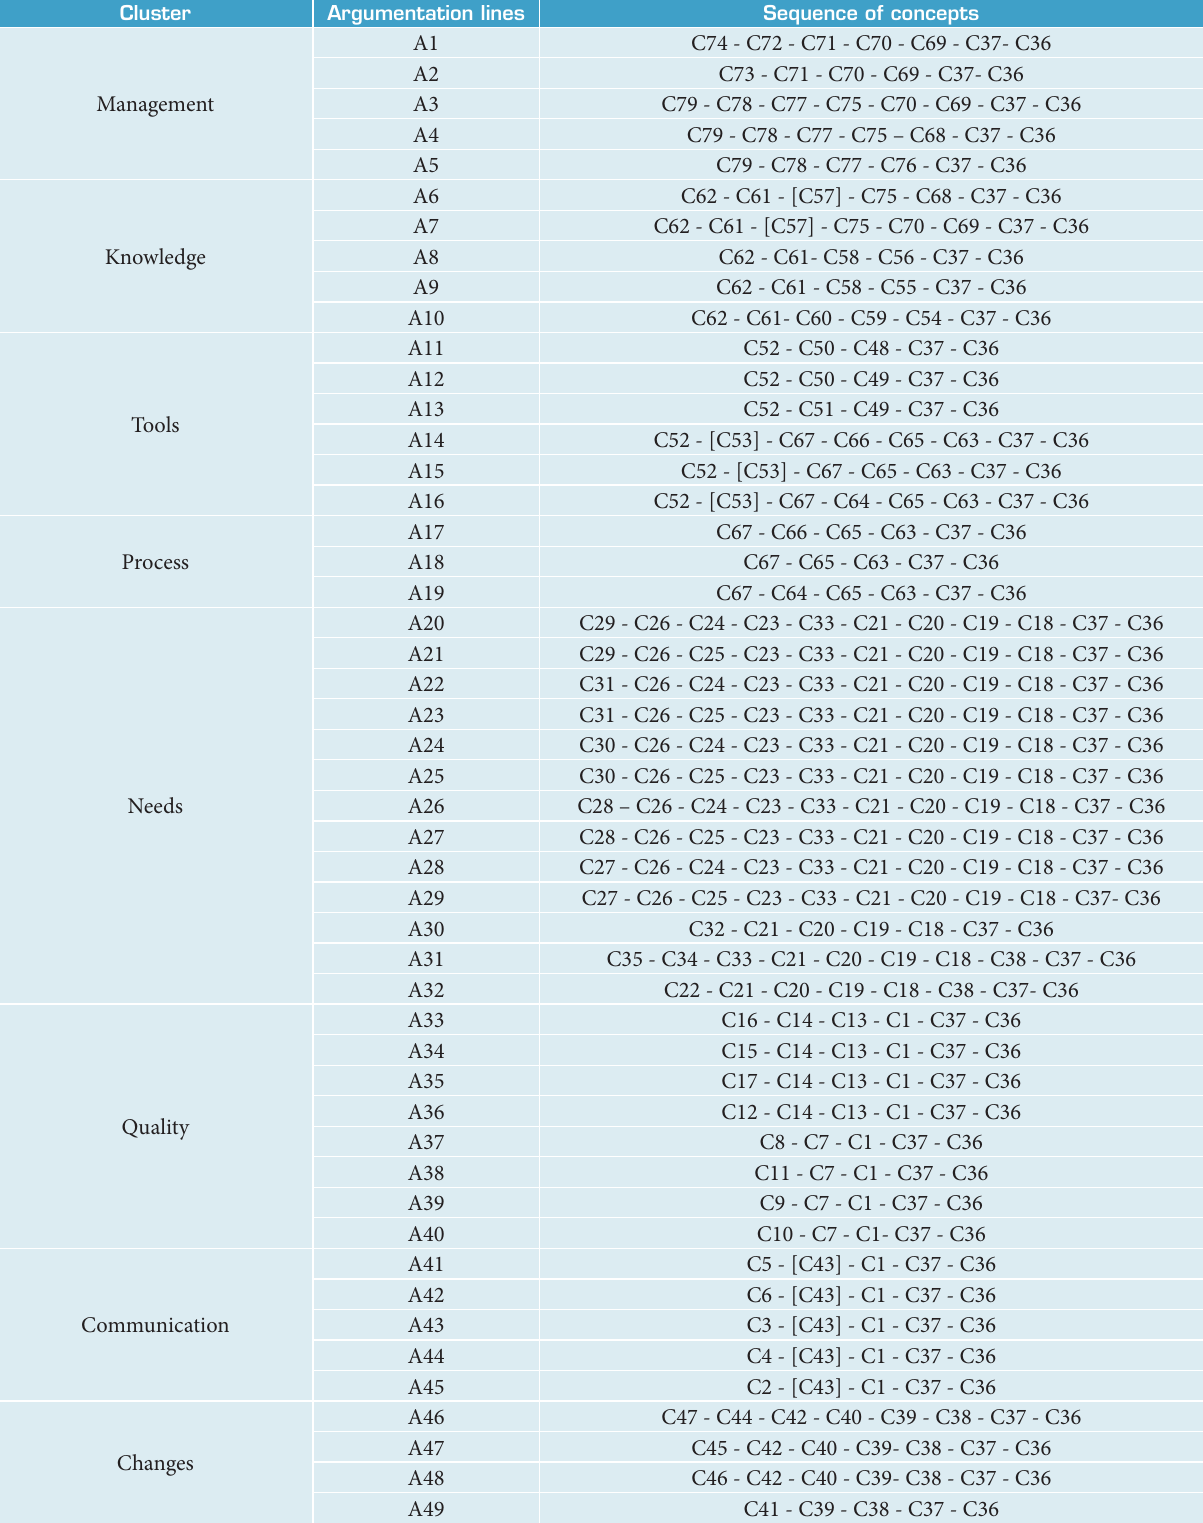
table 4. Argumentation